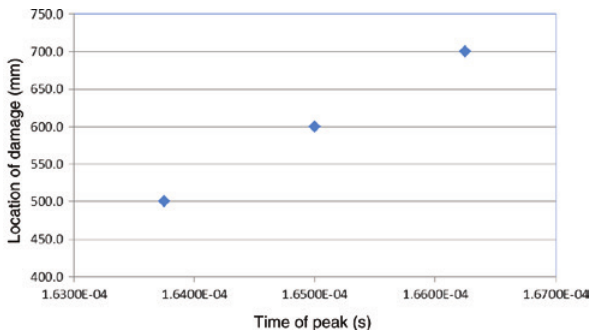
Figure 23: Arrival time of peak with varying damage locations.